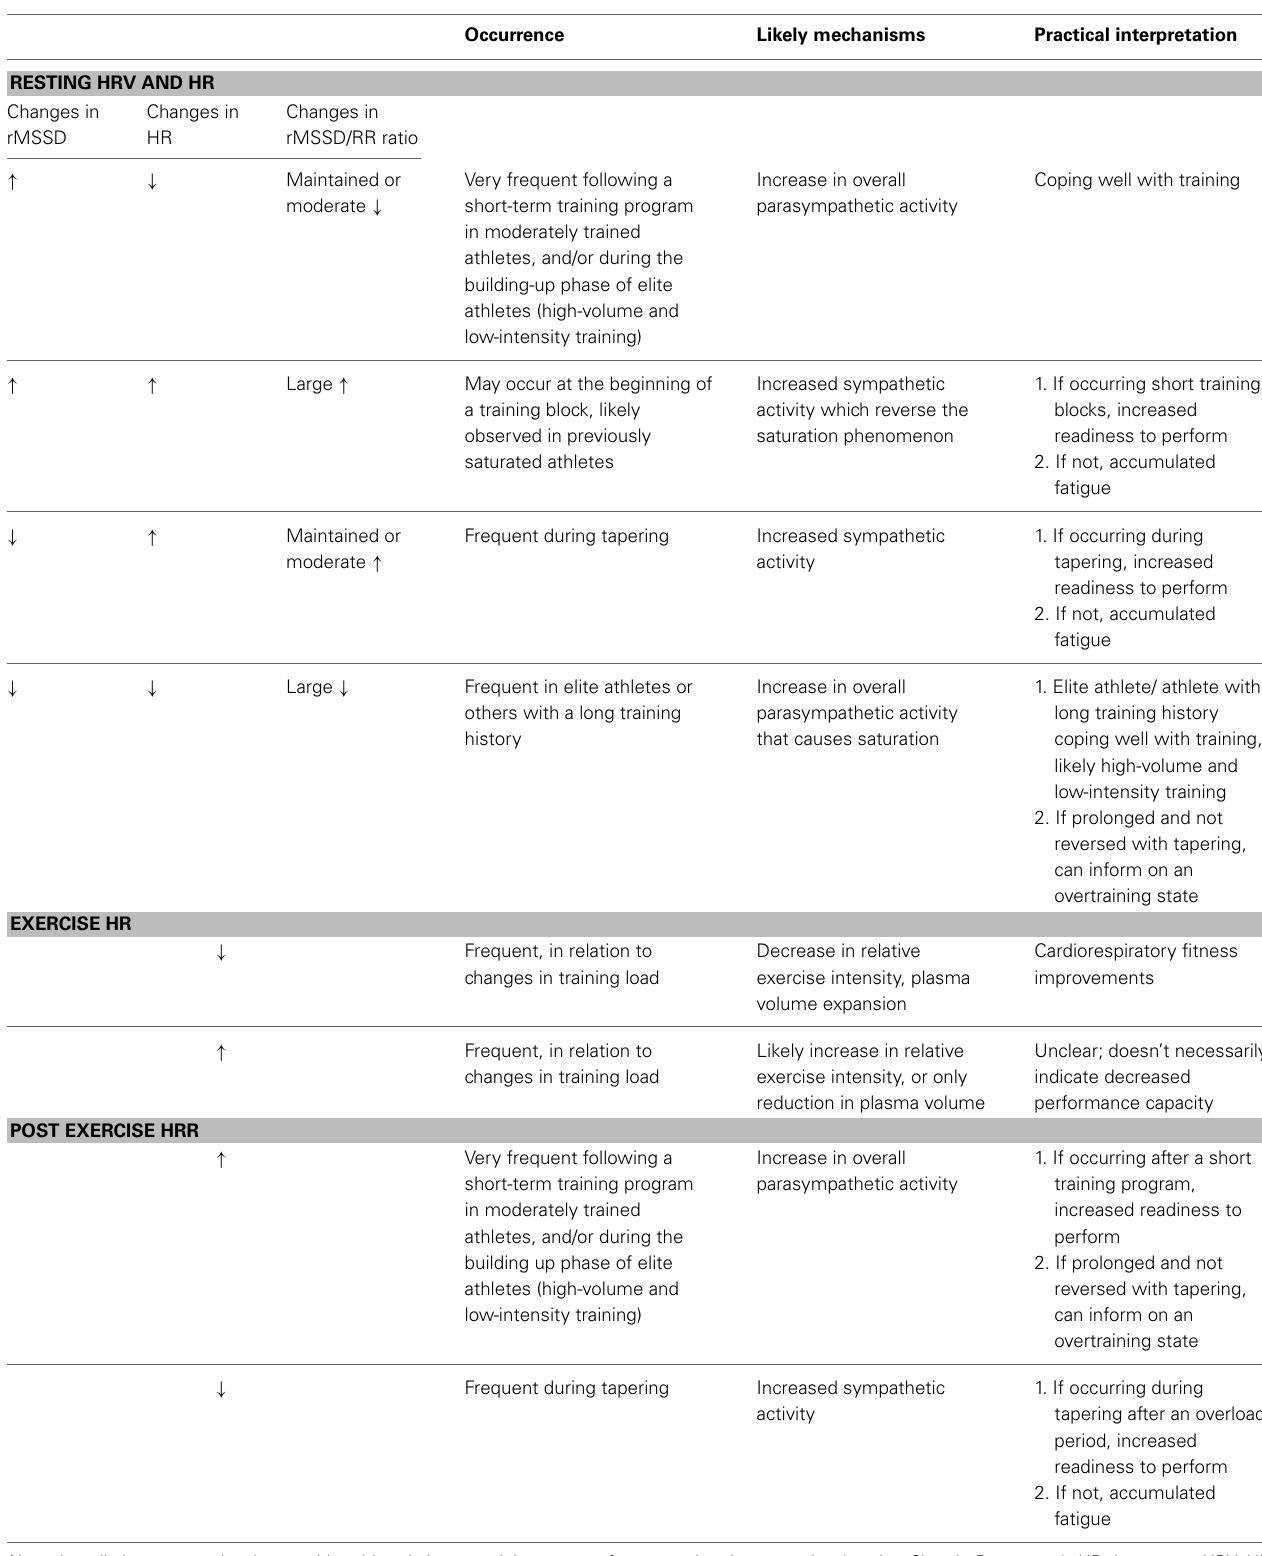
Table 2 | Guidelines for interpretation of chronic training status based on different scenarios in the changes in heart